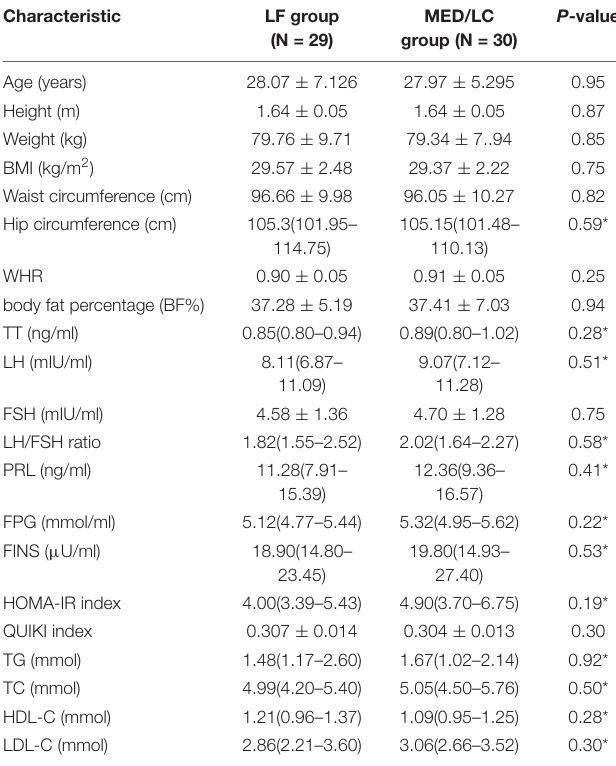
BMI, body mass index; WHR, waist-to-Hip Ratio; BF%, body fat percentage TT, total testosterone; LH, luteinizing hormone; FSH, follicle stimulating hormone; LH/FSH, ratio of luteinizing hormone to follicle stimulating hormone; PRL, prolactin; FPG, fasting plasma glucose; FINS, fasting insulin; HOMA-IR, homeostatic model assessment of insulin resistance; QUIKI, quantitative insulin sensitivity check index; TC, total cholesterol; TG, triglyceride; HDL-C, high-density lipoprotein cholesterol; LDL-C, low-density lipoprotein cholesterol. P Comparison between two groups has been assessed using independent t-test. Results are expressed as mean ± SD. *P Comparison between two groups has been assessed using Mann–Whitney tests. Results are expressed as median (25th–75th